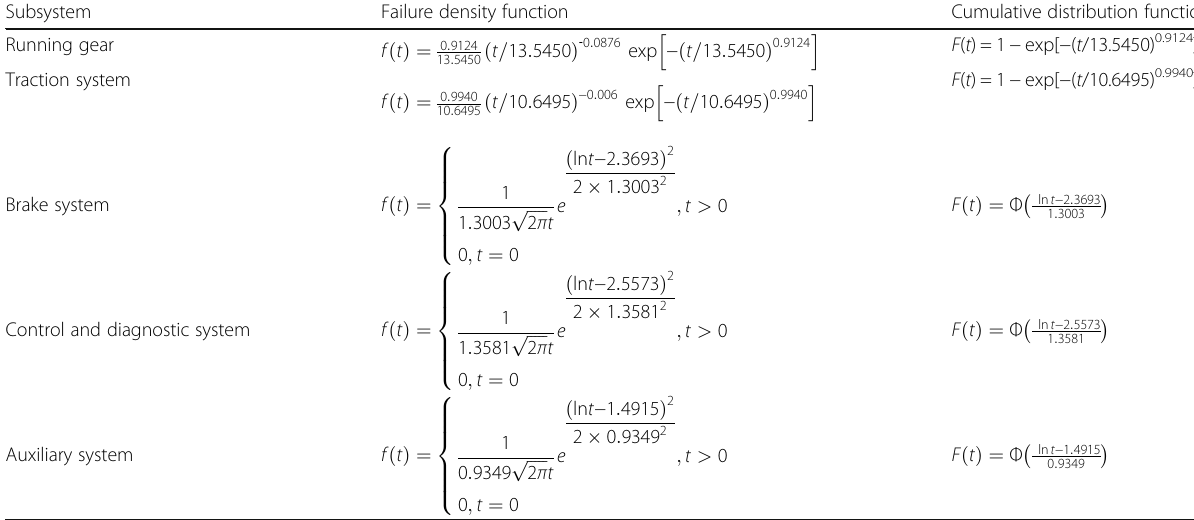
Table 2 The reliability characteristic functions of each subsystem Subsystem Failure density function Cumulative distribution